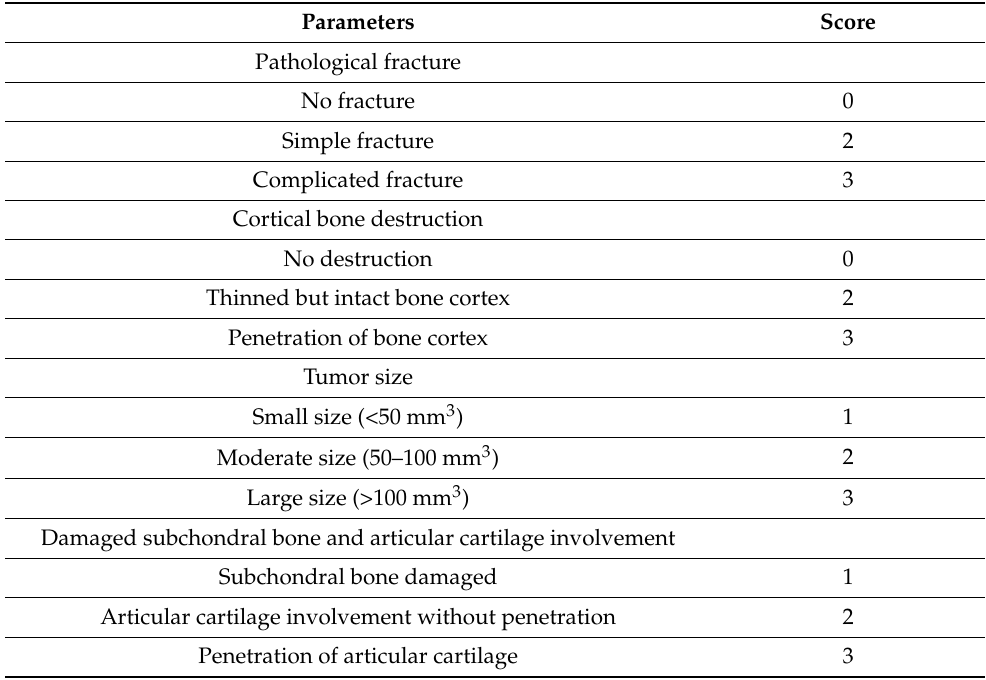
Table 1. Scoring system for giant cell tumors of the bone around the knee proposed by Lun et al. [66]. Parameters Score Pathological fracture No fracture 0